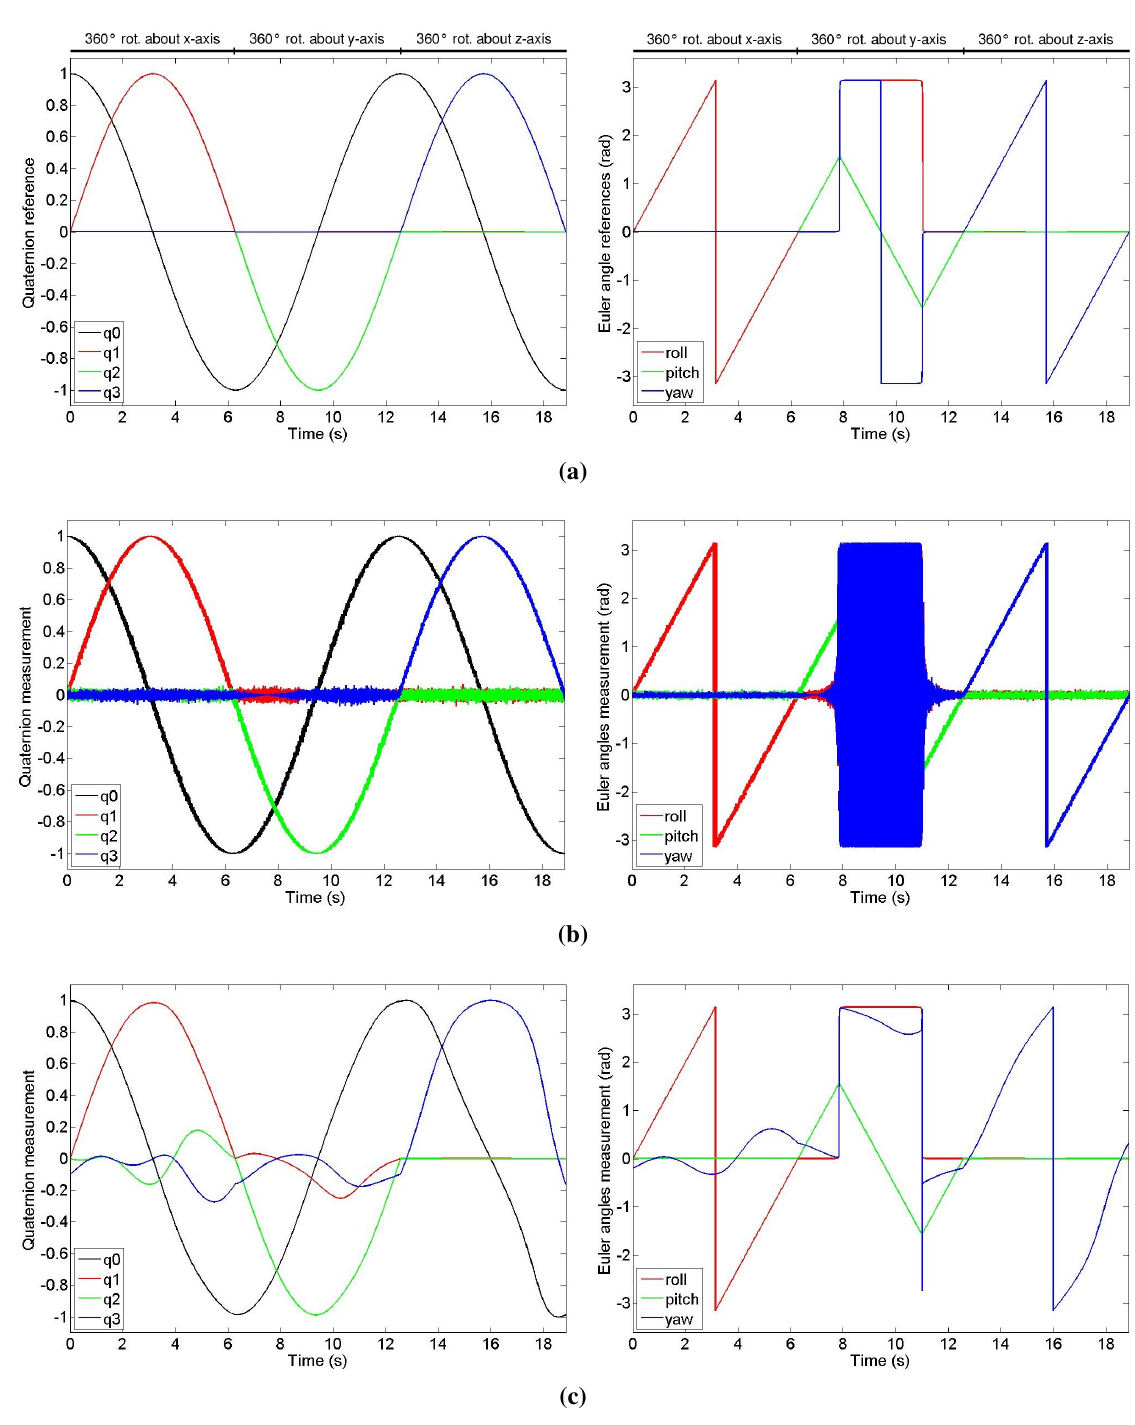
Figure 1. Simulated experiment showing the orientation output in quaternion form ( left ) and in Euler representation ( right ). of the presented method with noisy acceleration data and noise-free magnetometer data; ( c ) Orientation output of the presented method with noise-free acceleration data and magnetic readings affected by magnetic